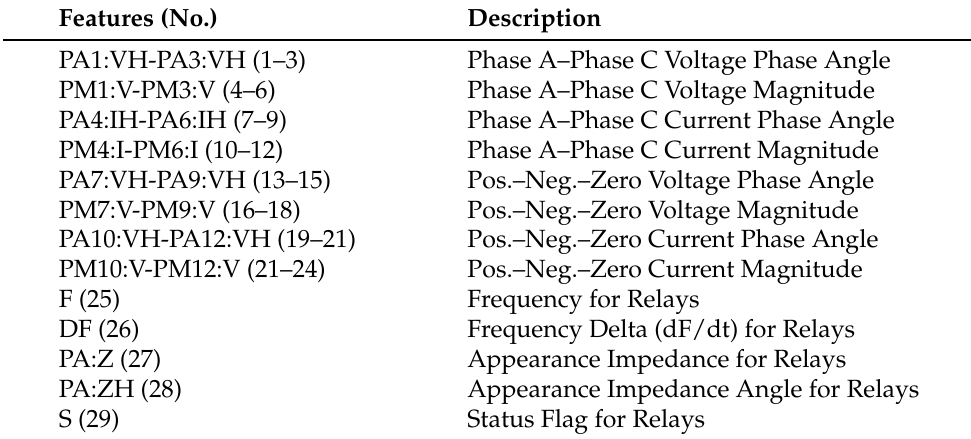
Table 2. Description of features measured by a